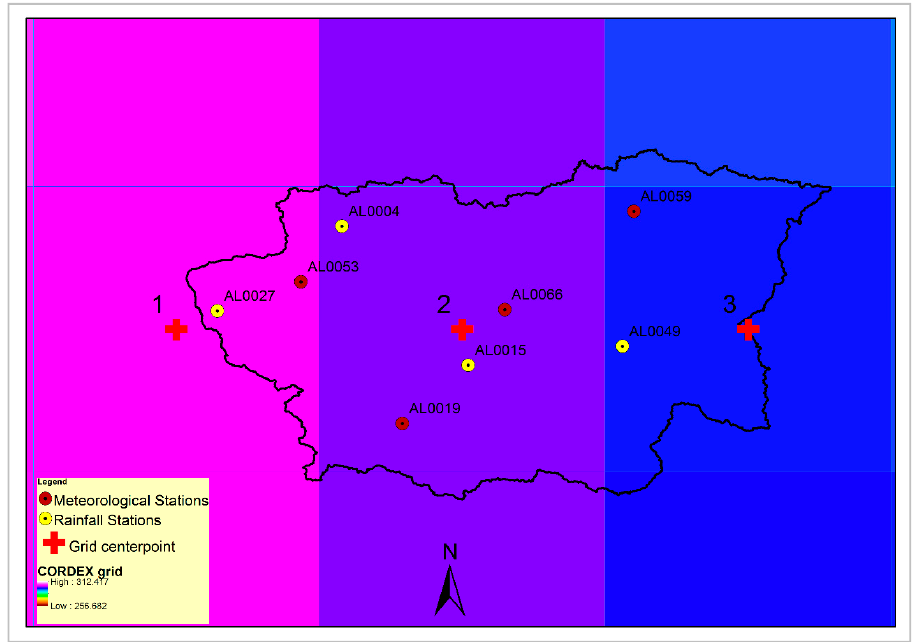
Figure 3. CORDEX grid center points and climate stations.